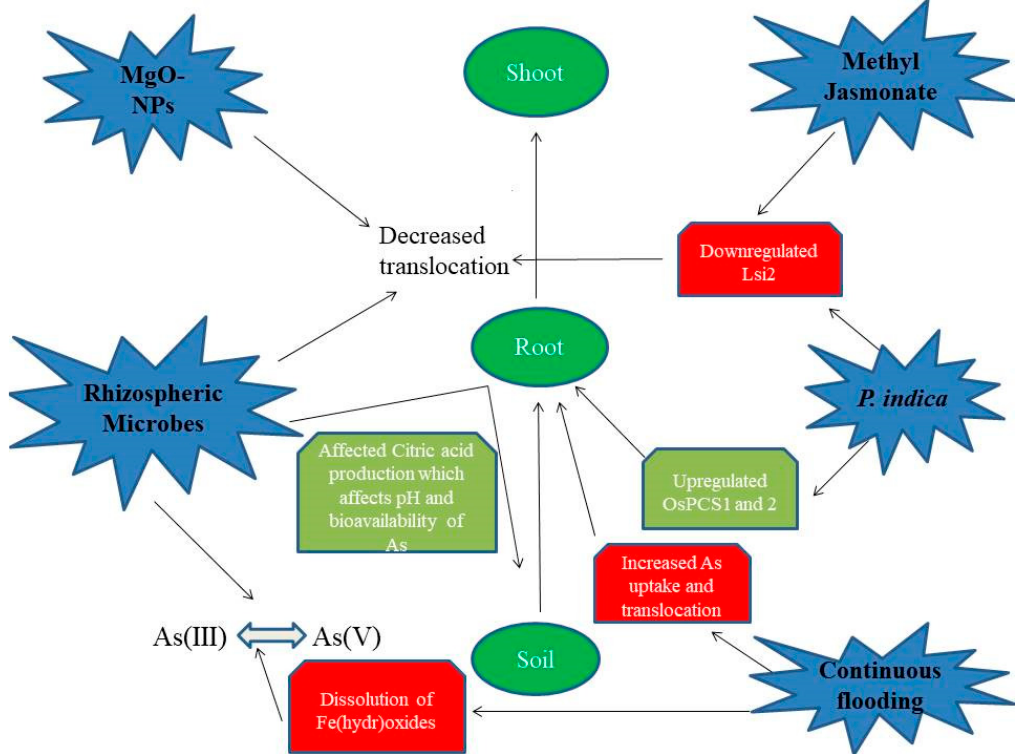
Figure 2. Remediation methods and their effects on the plant under arsenic (As) stress. Rhizospheric microbes regulate arsenic speciation, decrease translocation from root to shoot, and enhance citric acid production by roots, which in turn influences soil pH and bioavailability of arsenic in the soil. P. indica downregulates low silicon rice ( Lsi2 ) and upregulates phytochelatins encoding genes ( OsPCS1 and OsPCS2 ) which decrease As translocation to shoot. Continuous flooding increases arsenic uptake and translocation and regulates arsenic speciation in soil. Methyl jasmonate and magnesium oxide nanoparticles (MgO ‐ NPs) reduce arsenic translocation from root to shoot. (Adapted from [42,63,70].